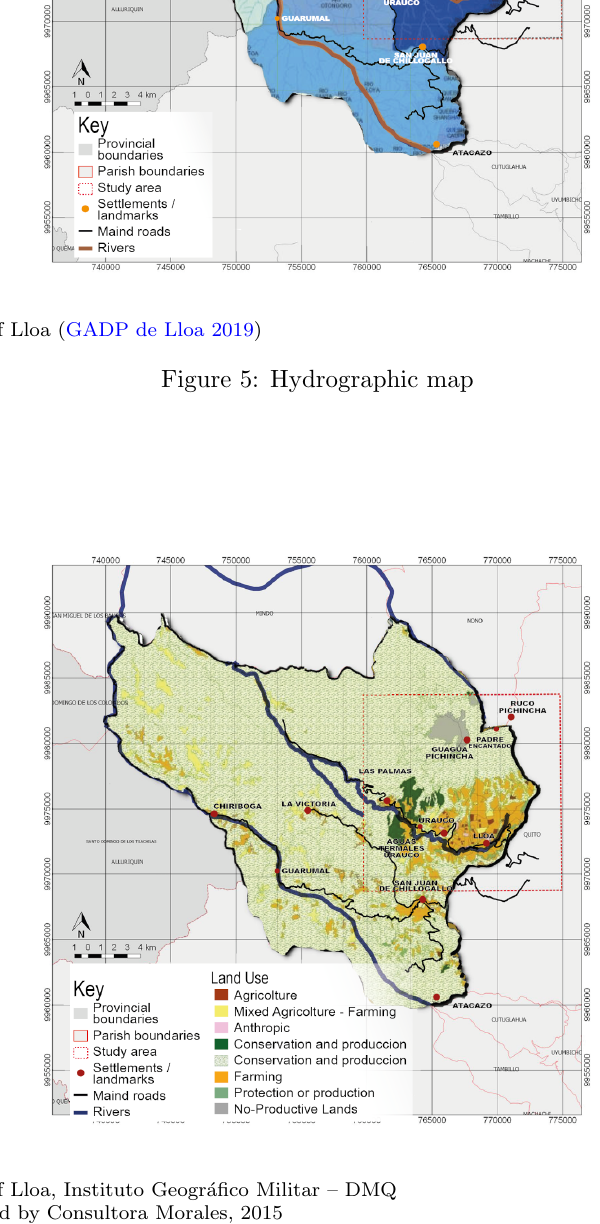
REGION : Volume 10, Number 1,